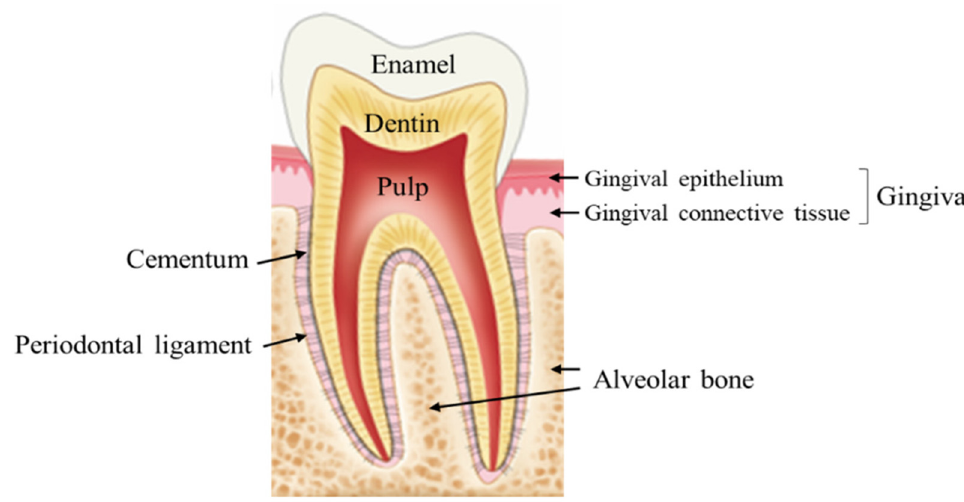
Figure 3. Diagrammatic demonstration of the periodontium encompassing the intact periodontal structures. The figure was adapted from Cho et al. (2021) [99].